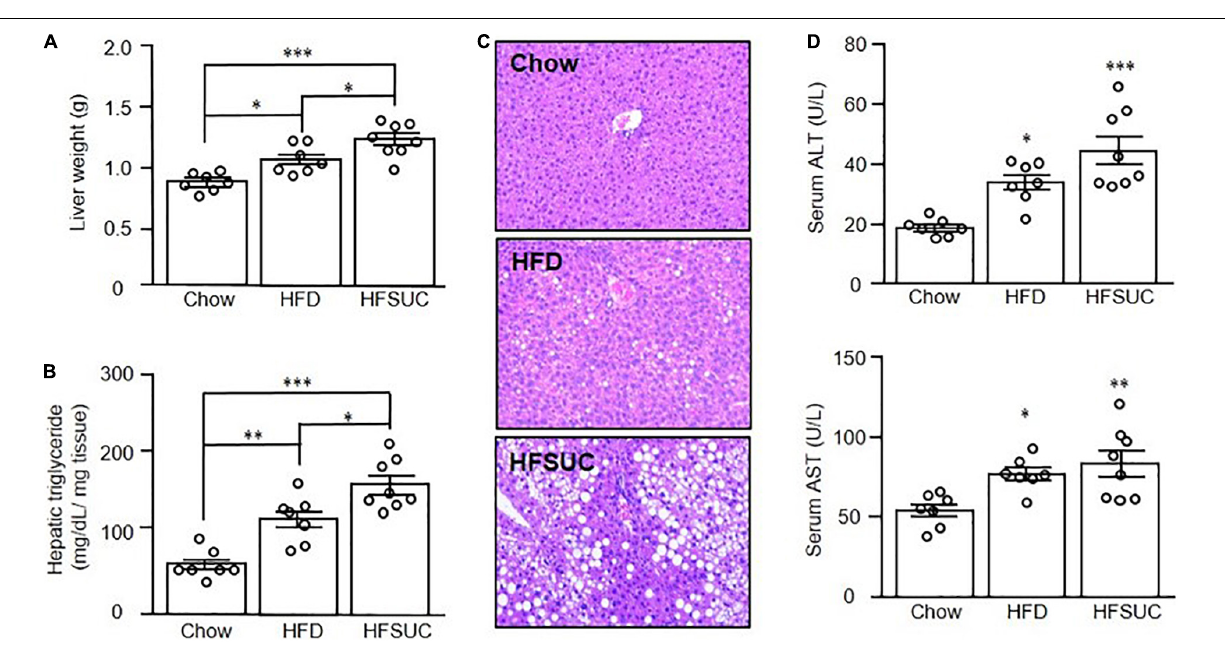
Frontiers in Nutrition |